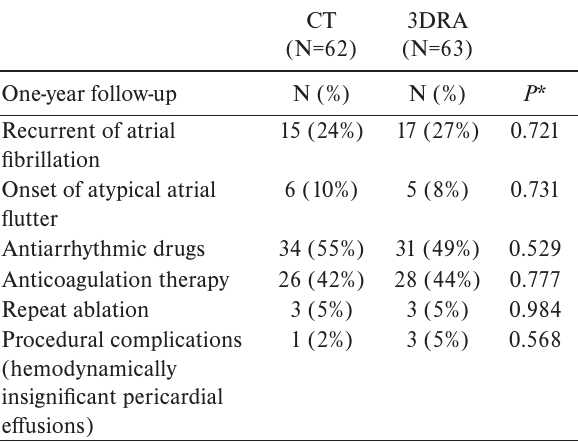
Table 3. Clinical